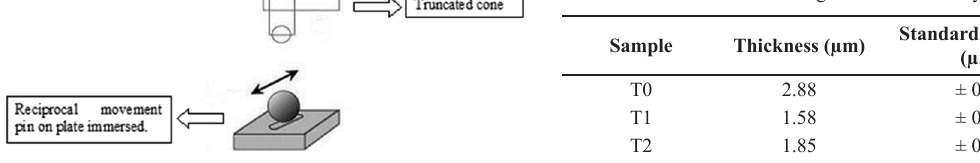
Table 1. Thickness of the resulting siloxane-PMMA hybrid